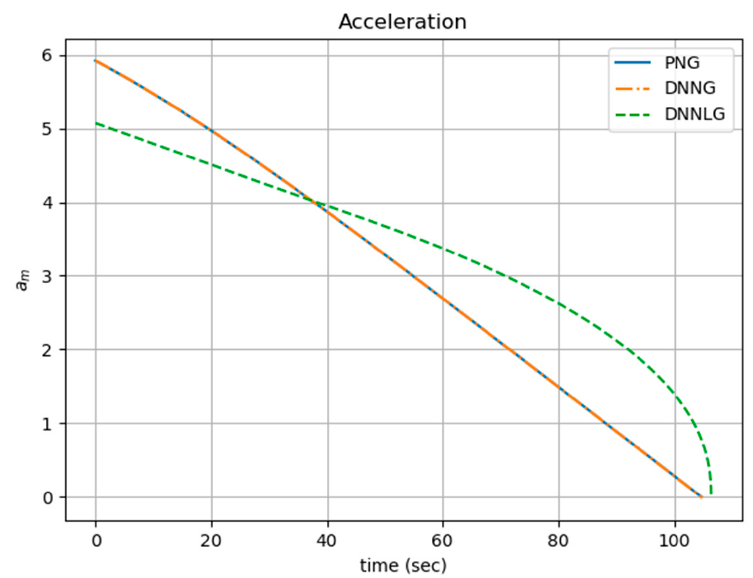
Figure 10. Comparison of the acceleration for all guidance law.